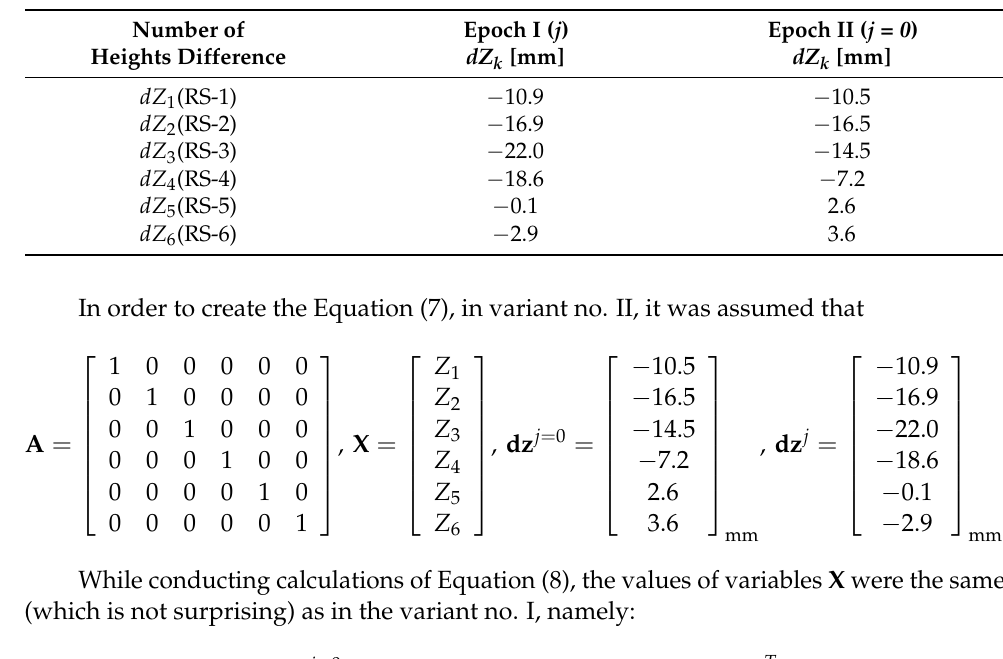
Table 3. The results dZ k obtained from epoch I and epoch